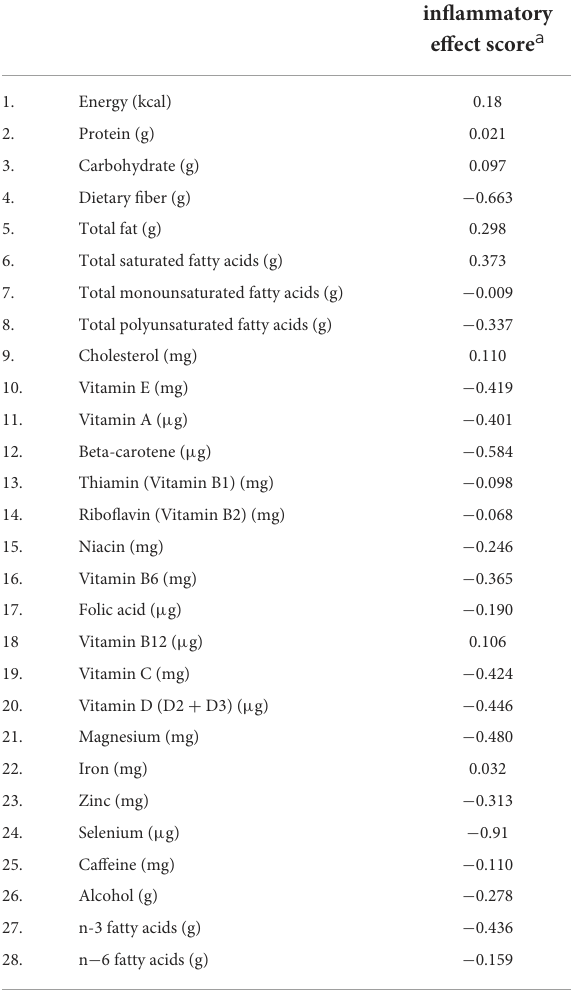
TABLE 1 Components of the dietary inflammatory index (DII) in this